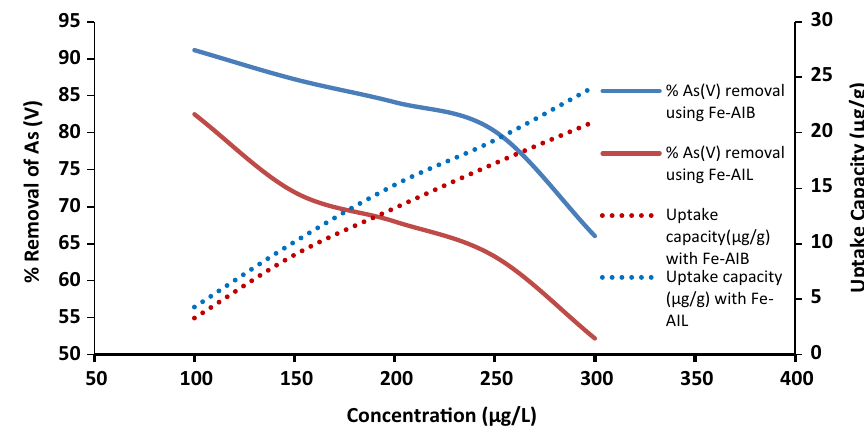
Fig. 8 Effect of initial arsenic concentration on adsorption of As (V) by Fe-AIB and